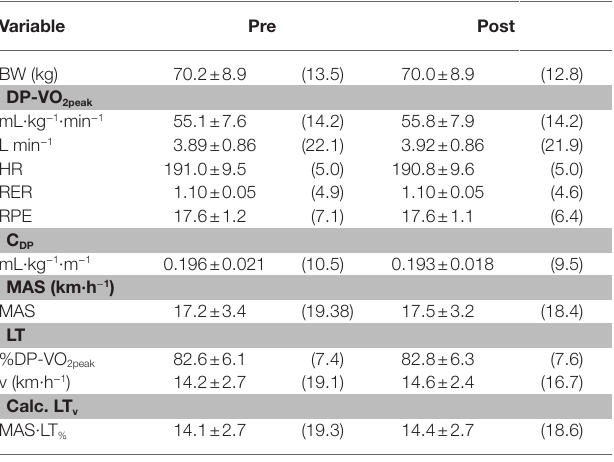
TABLE 2 | Physiological characteristics prior and post 3 months of regular training ( n =